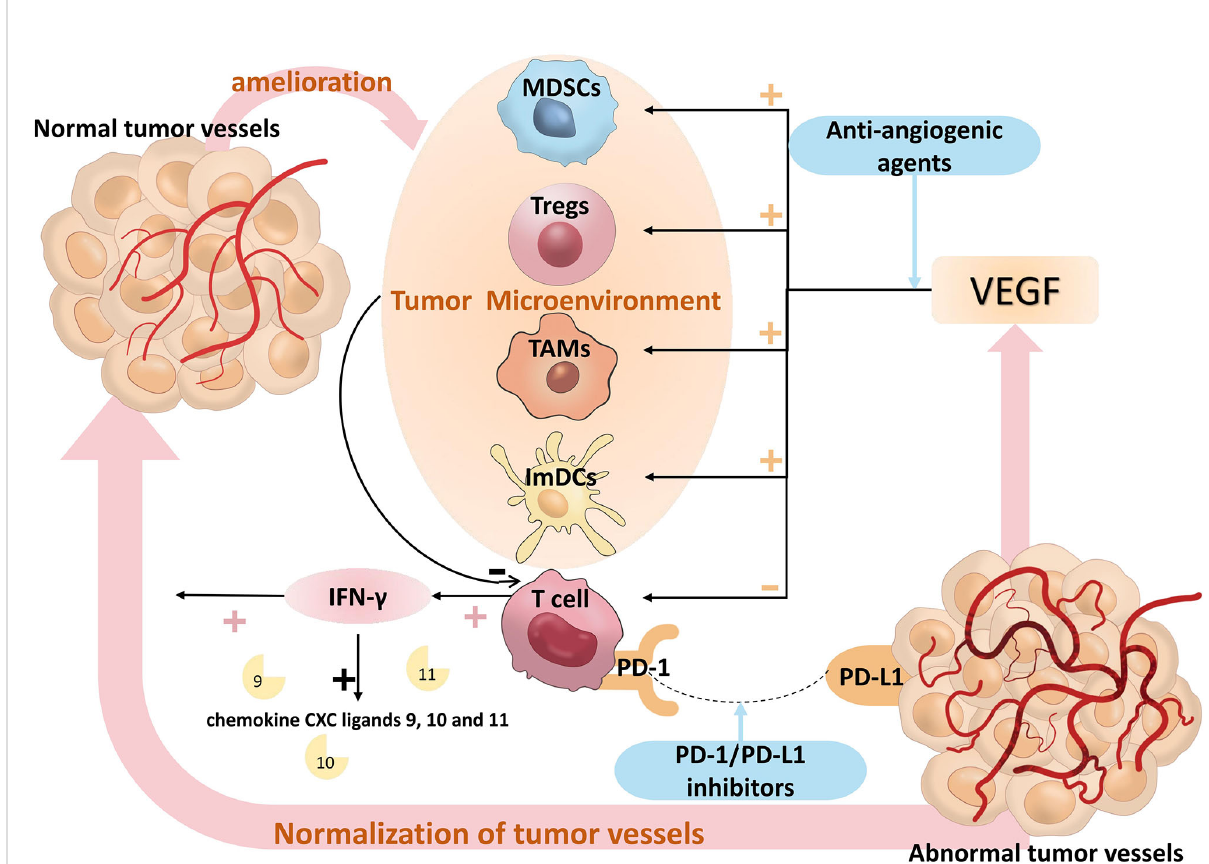
FIGURE 8 The relevant mechanisms of PD-1/PD-L1 inhibitors plus anti-angiogenic agents. T cells can be suppressed by members of the VEGF family, and VEGF can augment the suppressive actions of ImDCs, Tregs, TAMs, and MDSCs, which prevent T cells from having an anti-tumor impact. Anti- angiogenic agents inhibit the VEGF signaling pathway, which in turn activates T cells. T cells improve the tumor microenvironment by releasing IFN- g , and IFN- g upregulates chemokine CXC ligands 9, 10, and 11 to promote normalization of tumor vessels, thereby attenuating the effect of VEGF. PD-1/PD-L1 signaling pathway attenuates the anti-tumor activity of T cells, PD-1/PD-L1 inhibitors reactivate the anti-tumor activity of T cells, T cells improve the tumor microenvironment by releasing IFN- g , IFN- g upregulates chemokine CXC ligands 9, 10 and 11 to promote normalization of tumor vessels, thereby attenuating the effect of VEGF, which form a positive feedback loop between immunotherapy and anti- angiogenic therapy. VEGF, Vascular Endothelial Growth Factor; ImDCs, Immature Dendritic Cells; Treg, Regulatory T cells; TAMs, Tumor Associated Macrophages; MDSCs, Myeloid Derived Suppressor Cells. IFN- g , Interferon- g